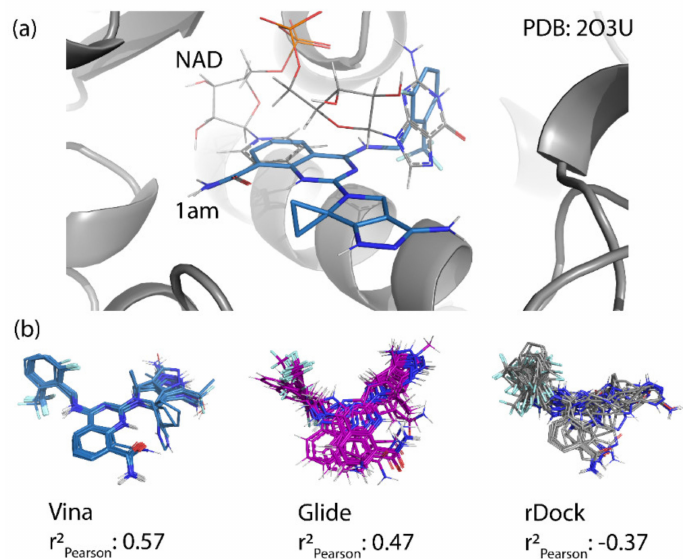
Figure 7. Examples of the pose predictions for some compounds from the Deaton et al. dataset. ( a ) The docked model for compound 1am using Vina (shown in blue) compared to the native pose of NAD observed in the structure 2O3U. ( b ) Top-scoring docked poses from twenty-fix random compounds from Vina, Glide, and rDock. Despite the similar sca ff olds, Glide and rDock had di ffi culties finding similar poses, which may have contributed to the higher variance in the predicted a ffi